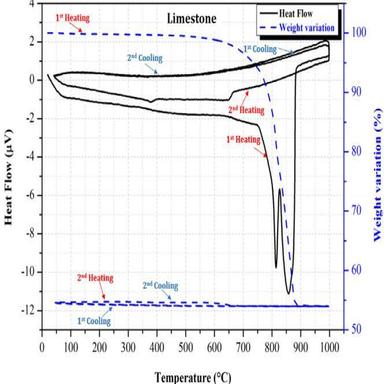
Mass loss and heat flow variation during two thermal cycles for Limestone rock.